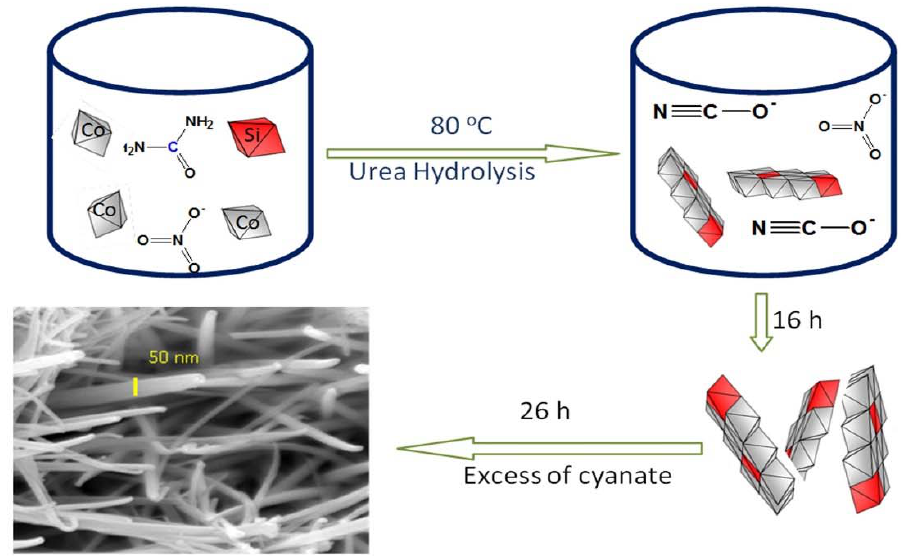
Figure 4. Schematic representation of the synthesis of 1D nanofibers.